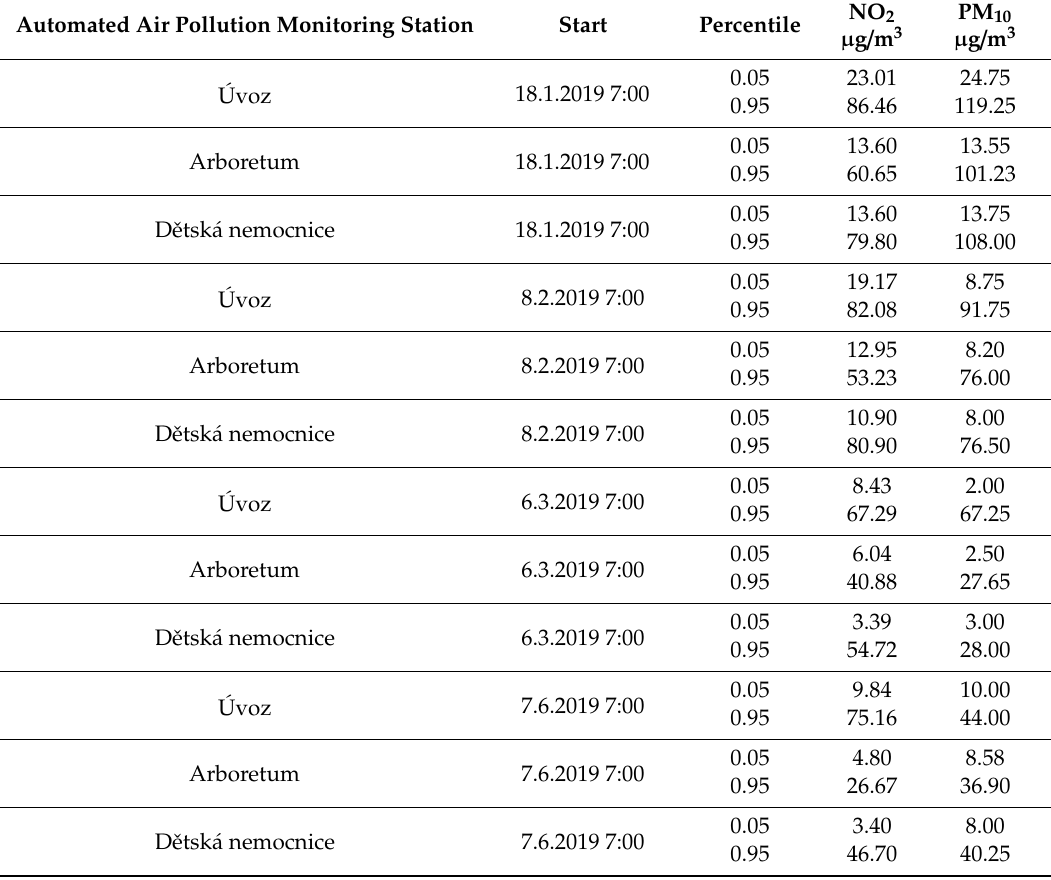
Table 4. The results of the measurement at the Automated Air Pollution Monitoring Stations—the 0.05 and 0.95 percentiles of the measured